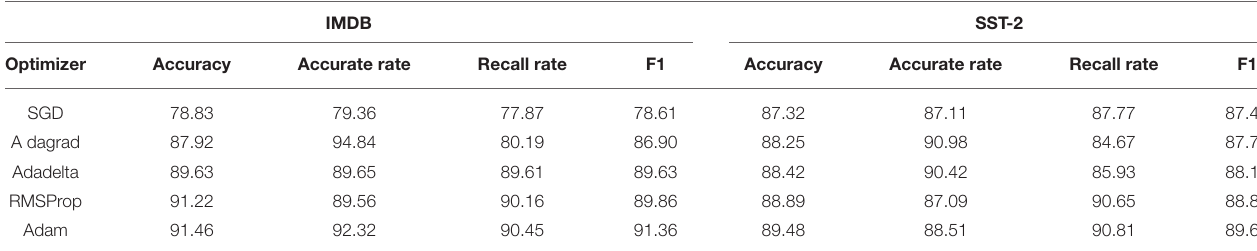
TABLE 7 | Experimental results of different optimizers.